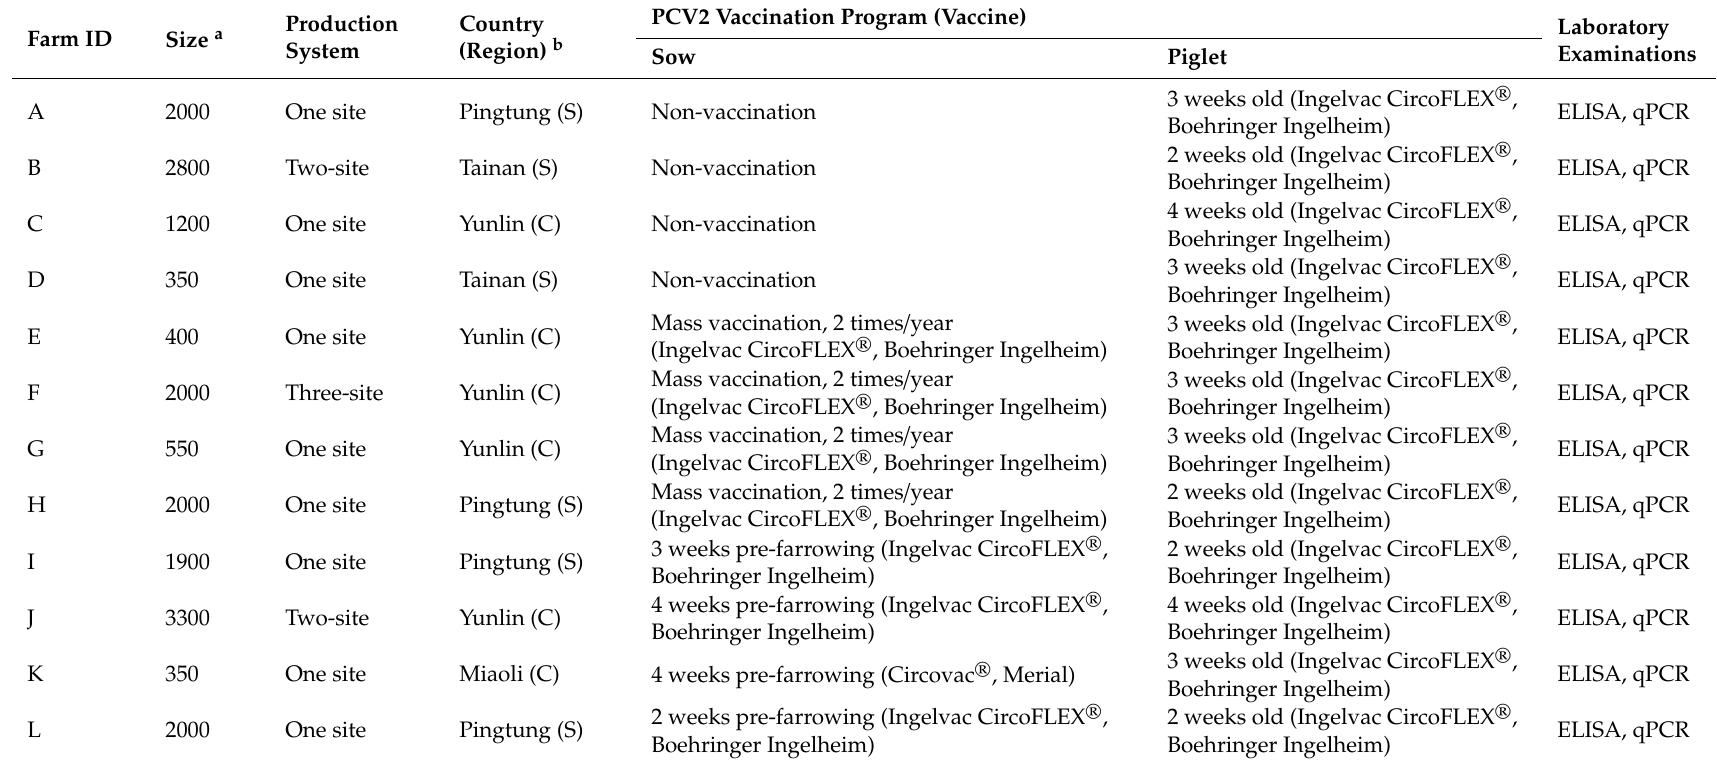
Table 1. Details of the pig herd characteristics in this retrospective